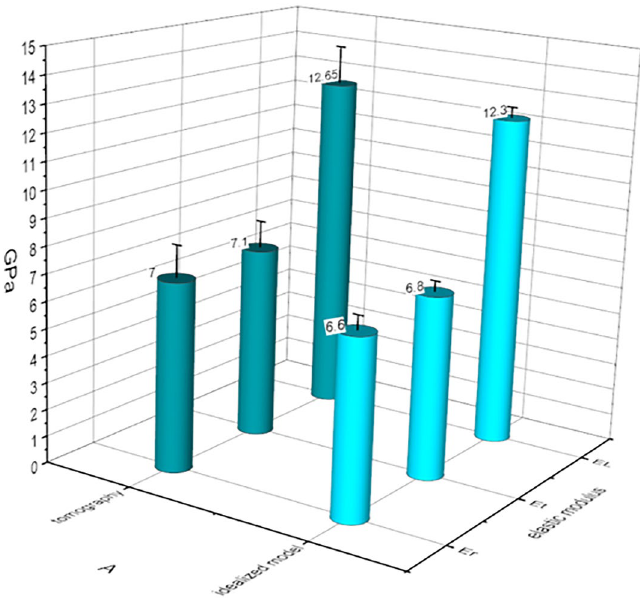
Figure 8. Summary of the computed elastic moduli of the native wall and its idealized model. Both exhibited transverse orthotropic behavior where the longitudinal modulus was almost twice as stiff as the radial/tangential elastic modulus and showed similar nano-mechanical properties in all three directions of the fiber